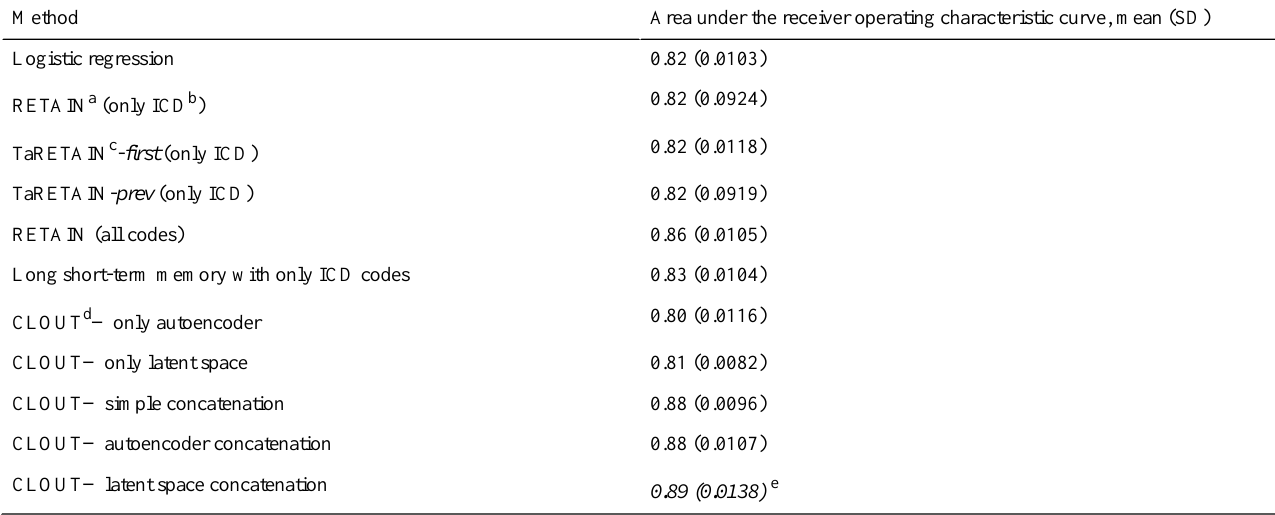
Table 2. Area under the receiver operating characteristic curve scores for different models.